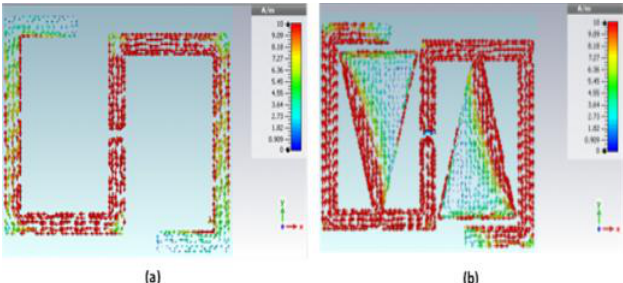
Figure 3: Simulated distributed current of the proposed structure with and without the triangular stubs at the resonance